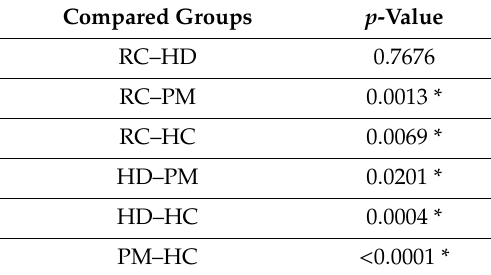
Table 4. Pairwise comparison according to